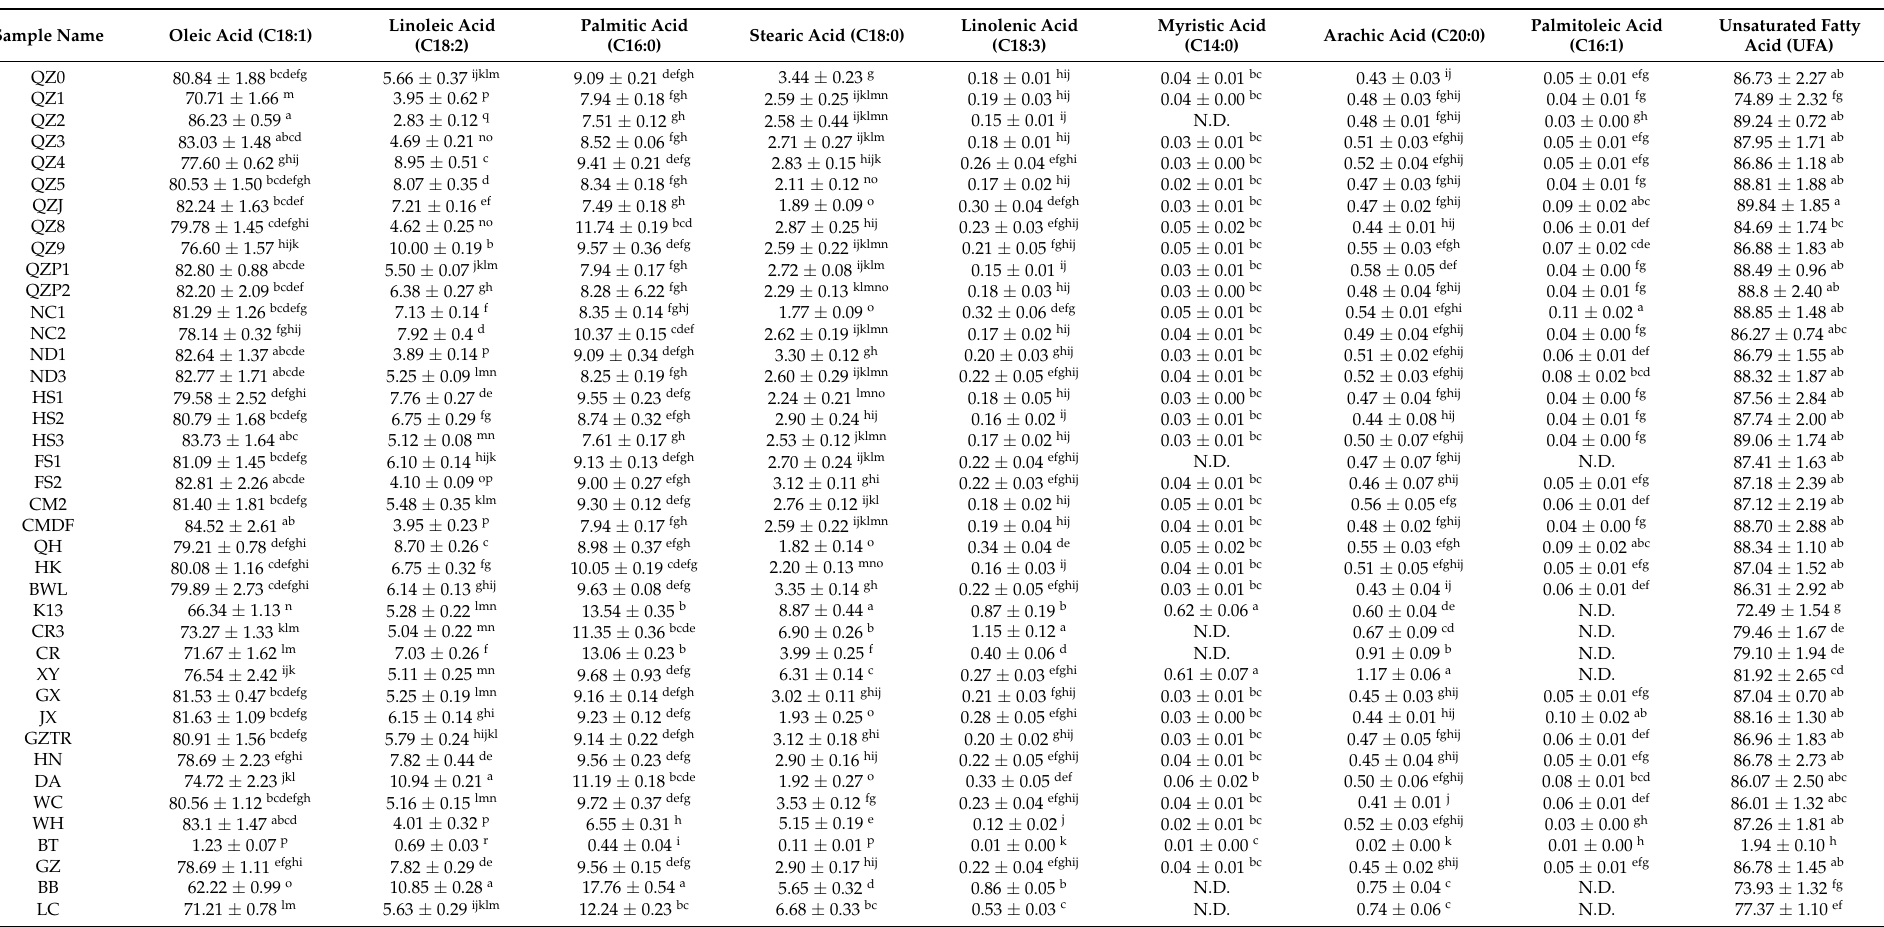
Table 3. Fatty acid compositions of the 40 samples